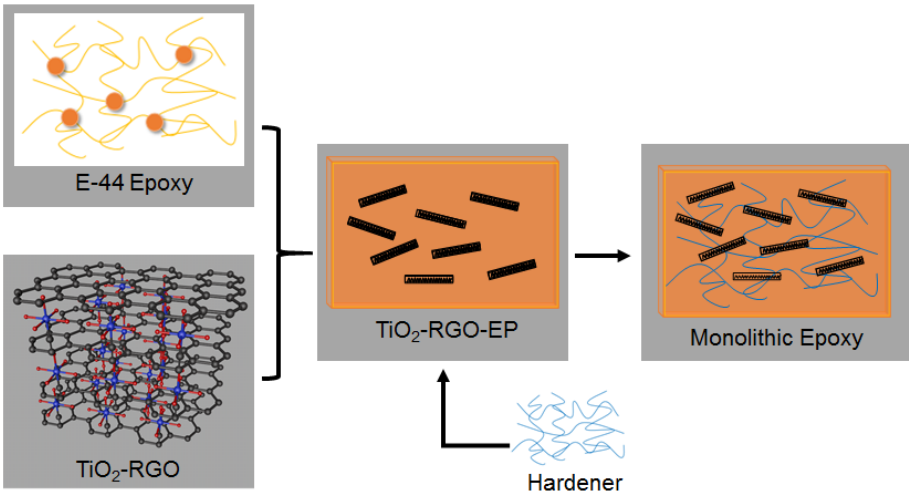
Figure 2. Schematic diagram for the preparation of TiO 2 -RGO-EP composites.